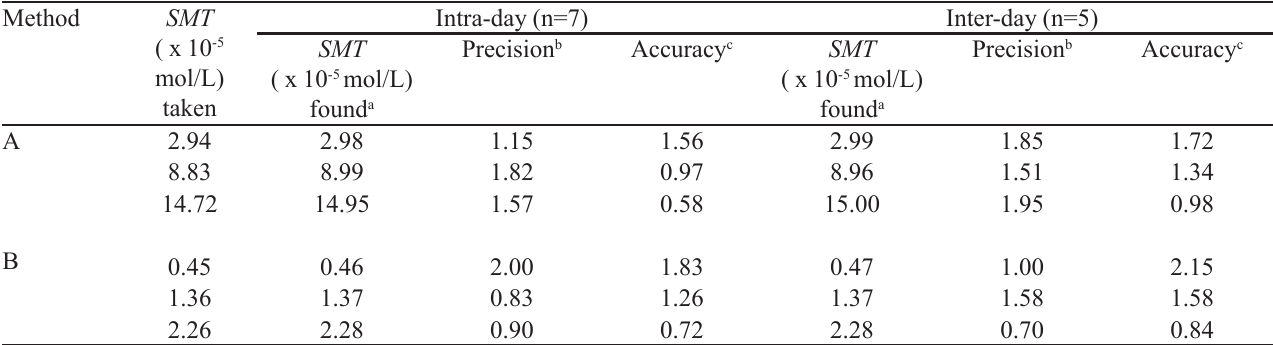
TABLE II - Intra-day and Inter-day precision and accuracy evaluation